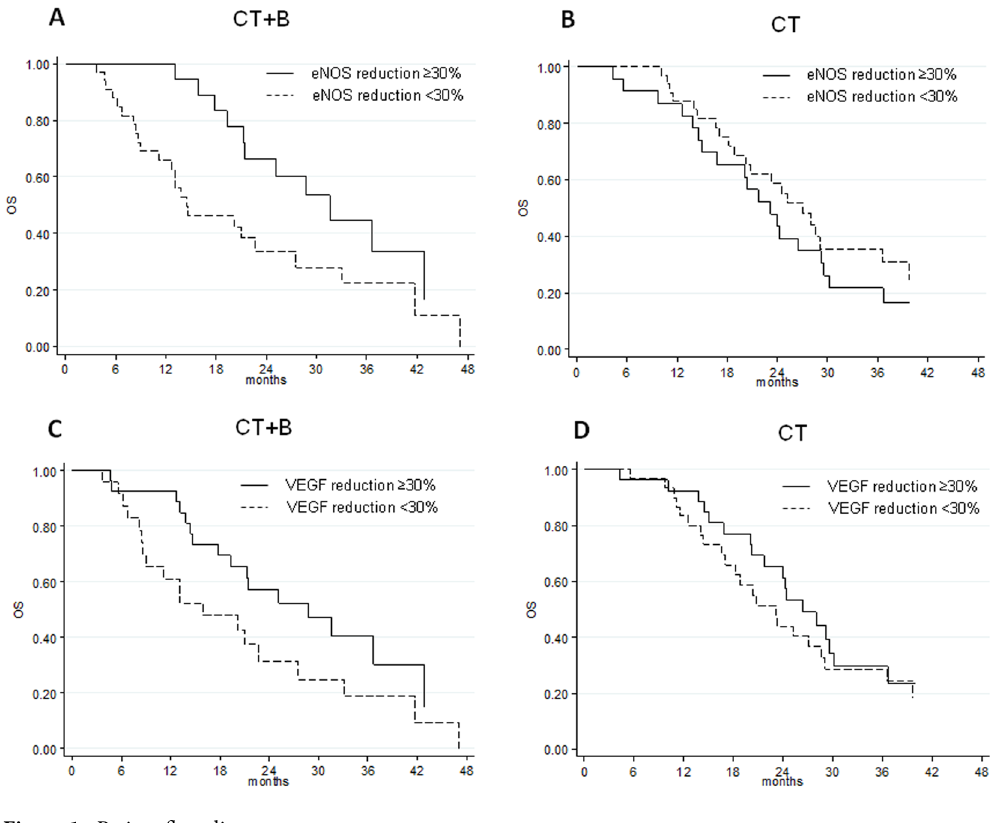
Figure 1. Patient flow diagram.